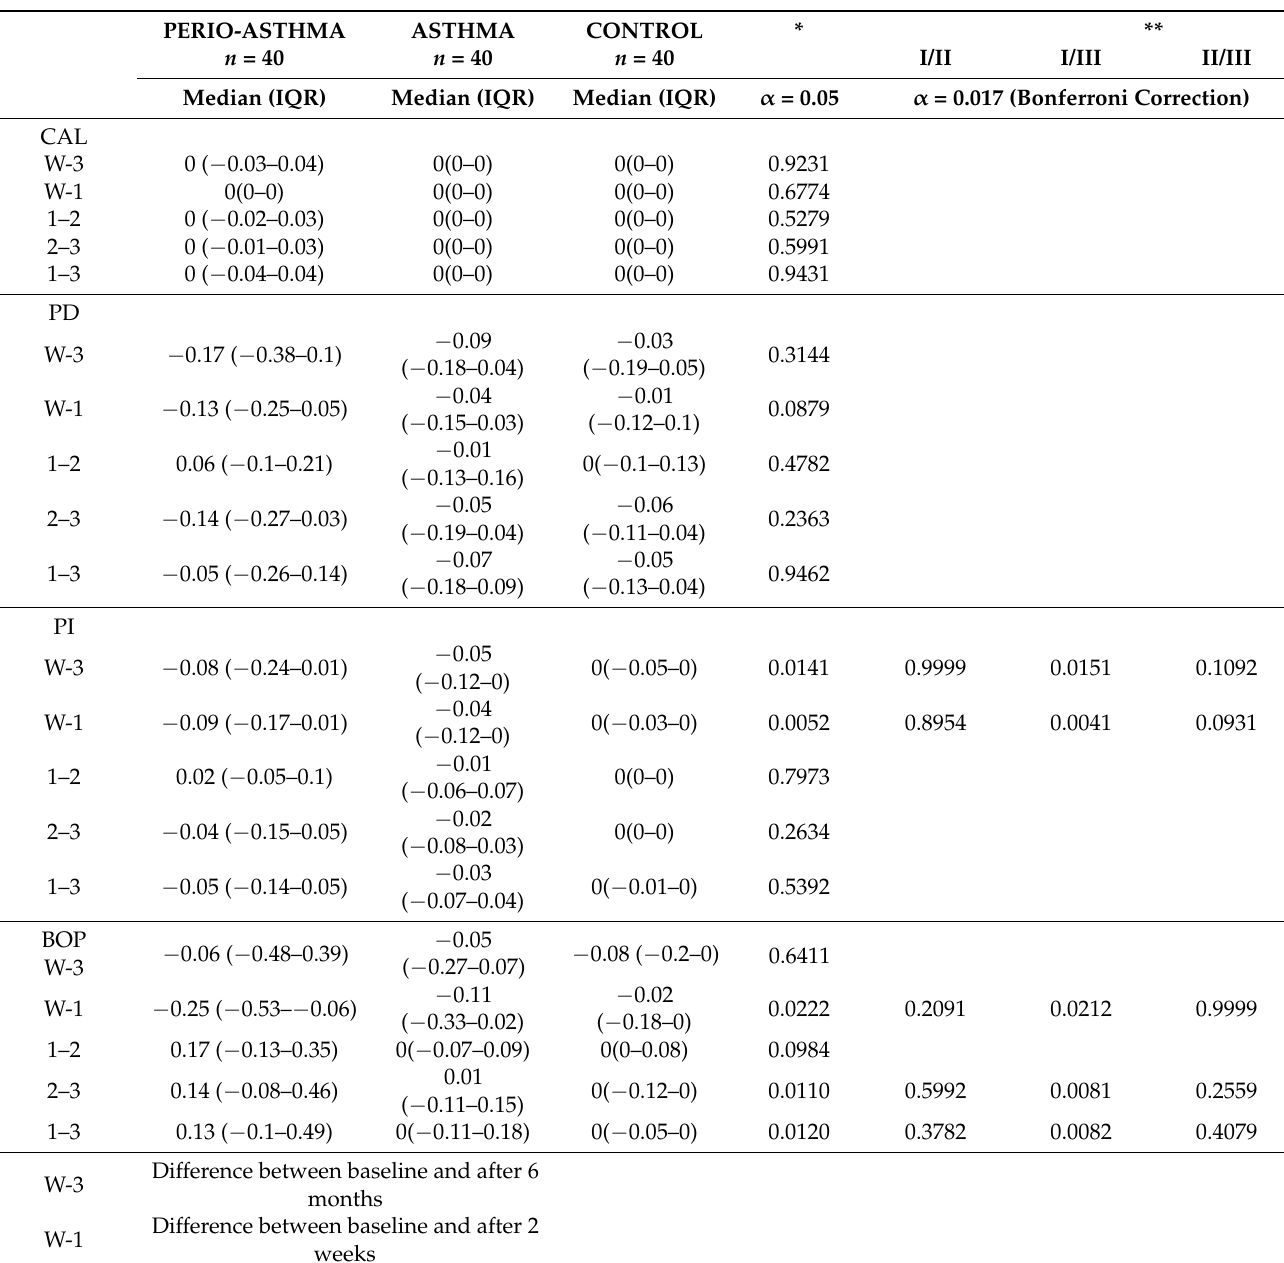
Table 5. Intergroup comparison of differences between studies of selected variables (CAL, PD, PI, BOP)—for the whole